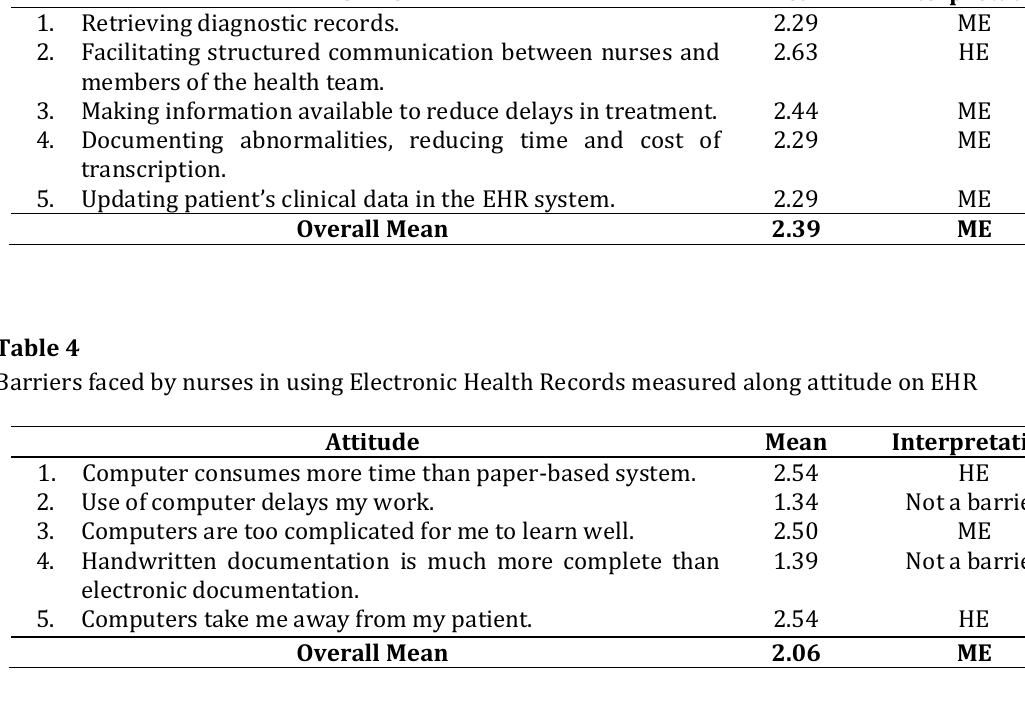
Barriers faced by nurses measured along skills on EHR Skills Mean Interpretation